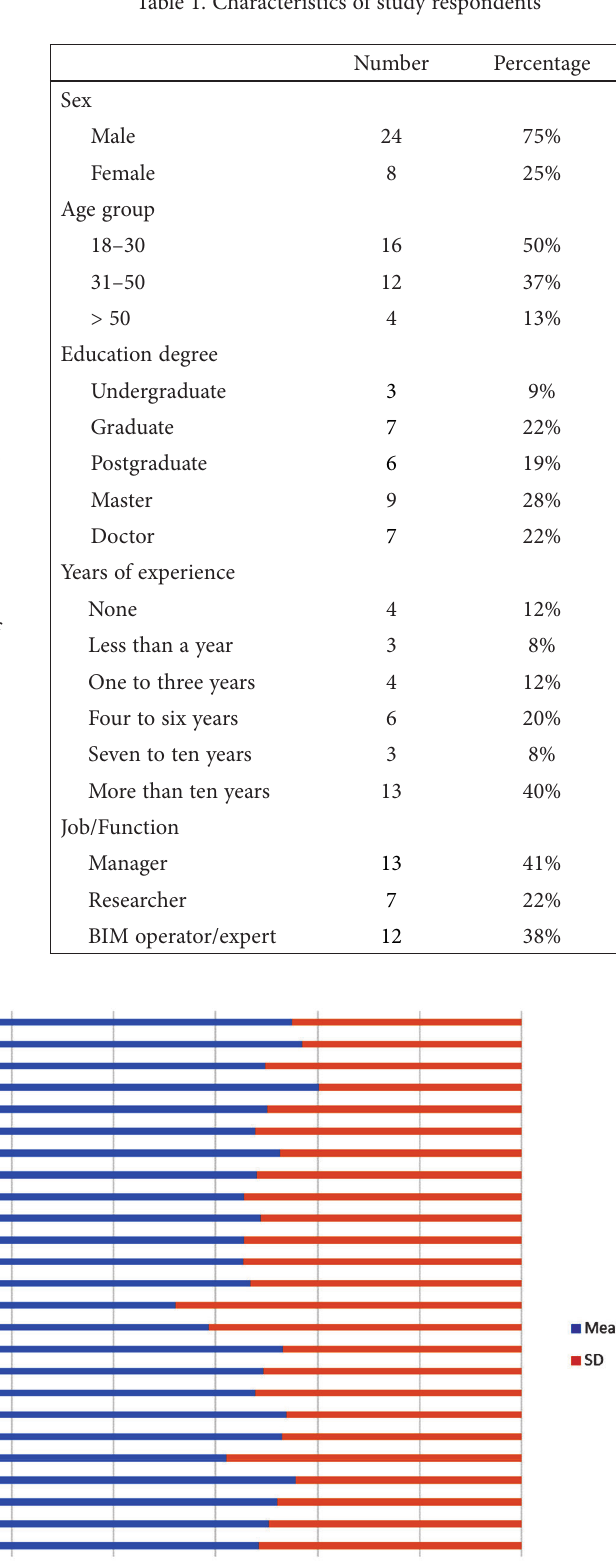
Table 1. Characteristics of study respondents